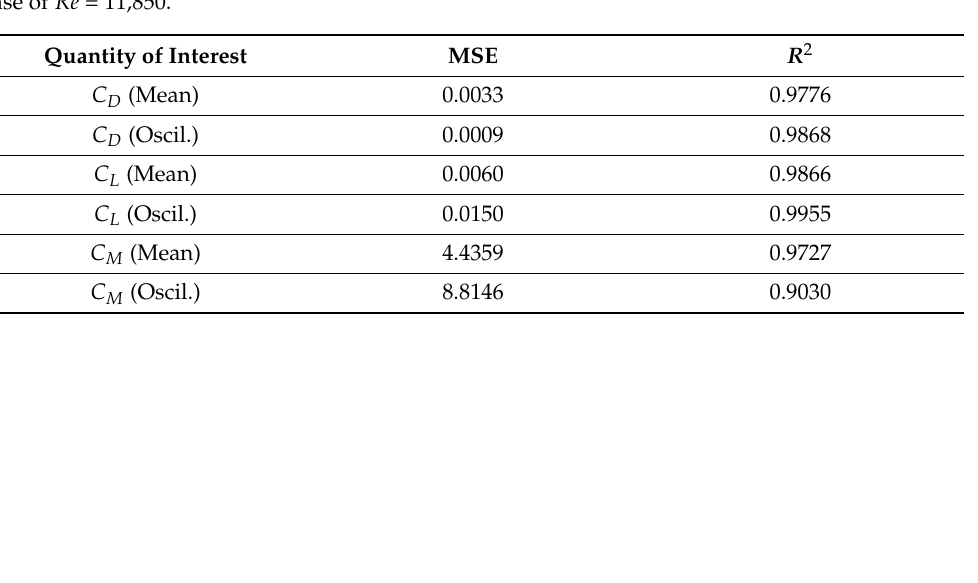
Figure 6. Examples of surrogate models of the drag coefficient in terms of 𝜇 𝒀(cid:3553) : ( a ) Mean and ( b ) Oscillation amplitude.